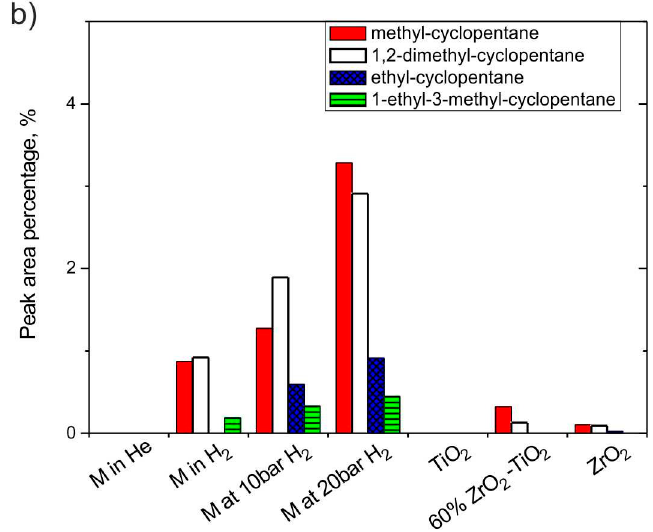
Figure 9. The peak area percentages of cyclo-alkanes: ( a ) cyclohexane derivatives, and ( b ) cyclopentane derivatives.